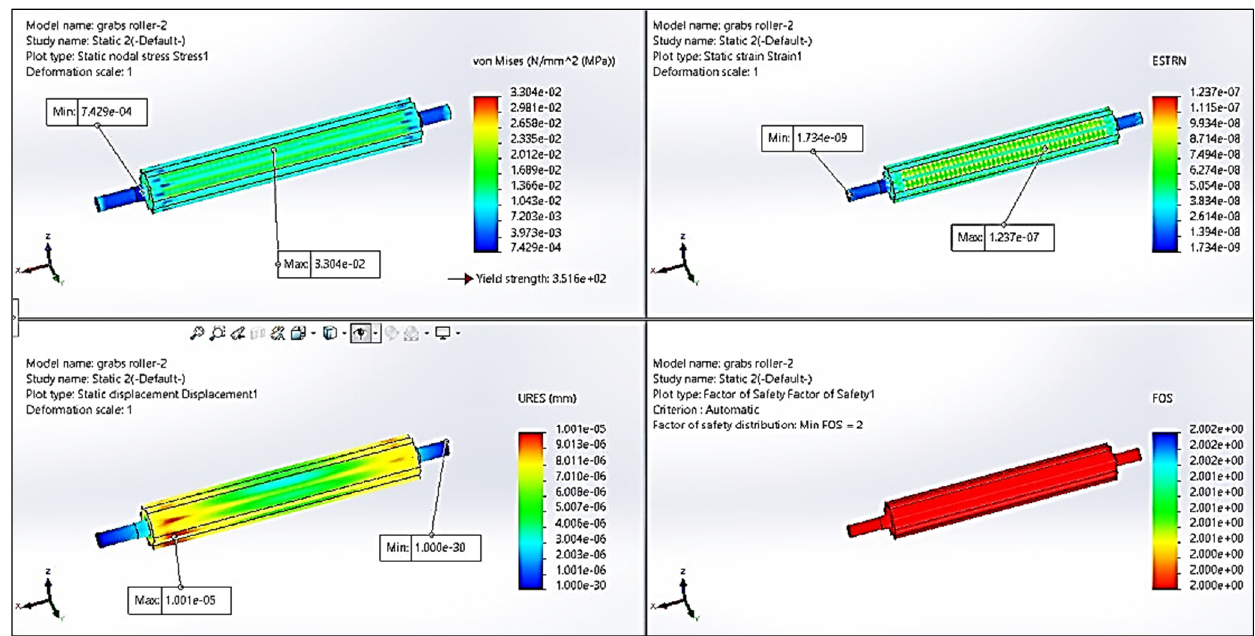
Figure 12. Stress, strain, displacement, and factor of safety of the grabbing roller with a 200 N force considered.